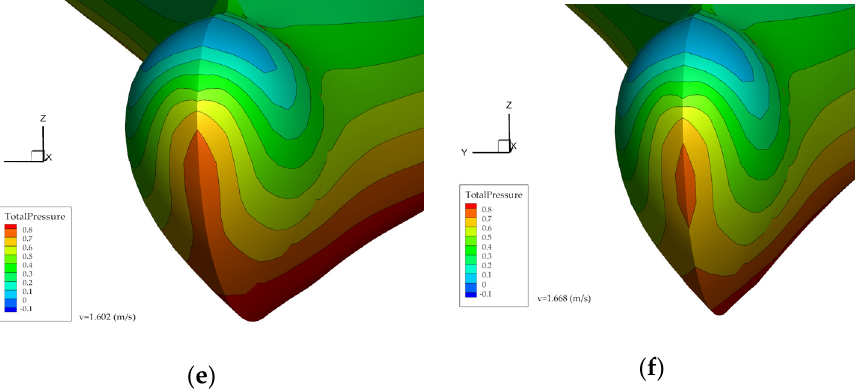
Figure 10. Total pressure (N/ m (cid:2870) ) for all speeds (Tecplot): ( a ) v = 1.335 m/s; ( b ) v = 1.401 m/s; (c) v = 1.469 m/s; ( d ) v = 1.535 m/s; ( e ) v = 1.602 m/s; ( f ) v = 1.668 m/s.